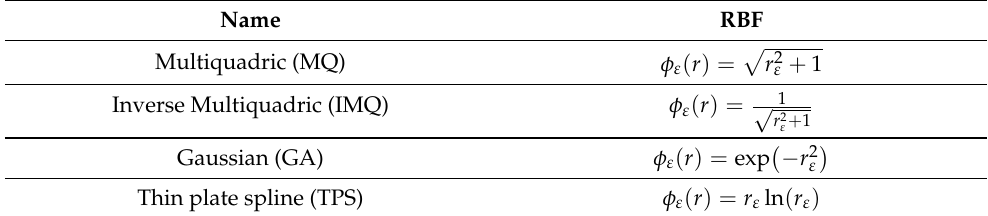
Table 1. Some choices of radial basis